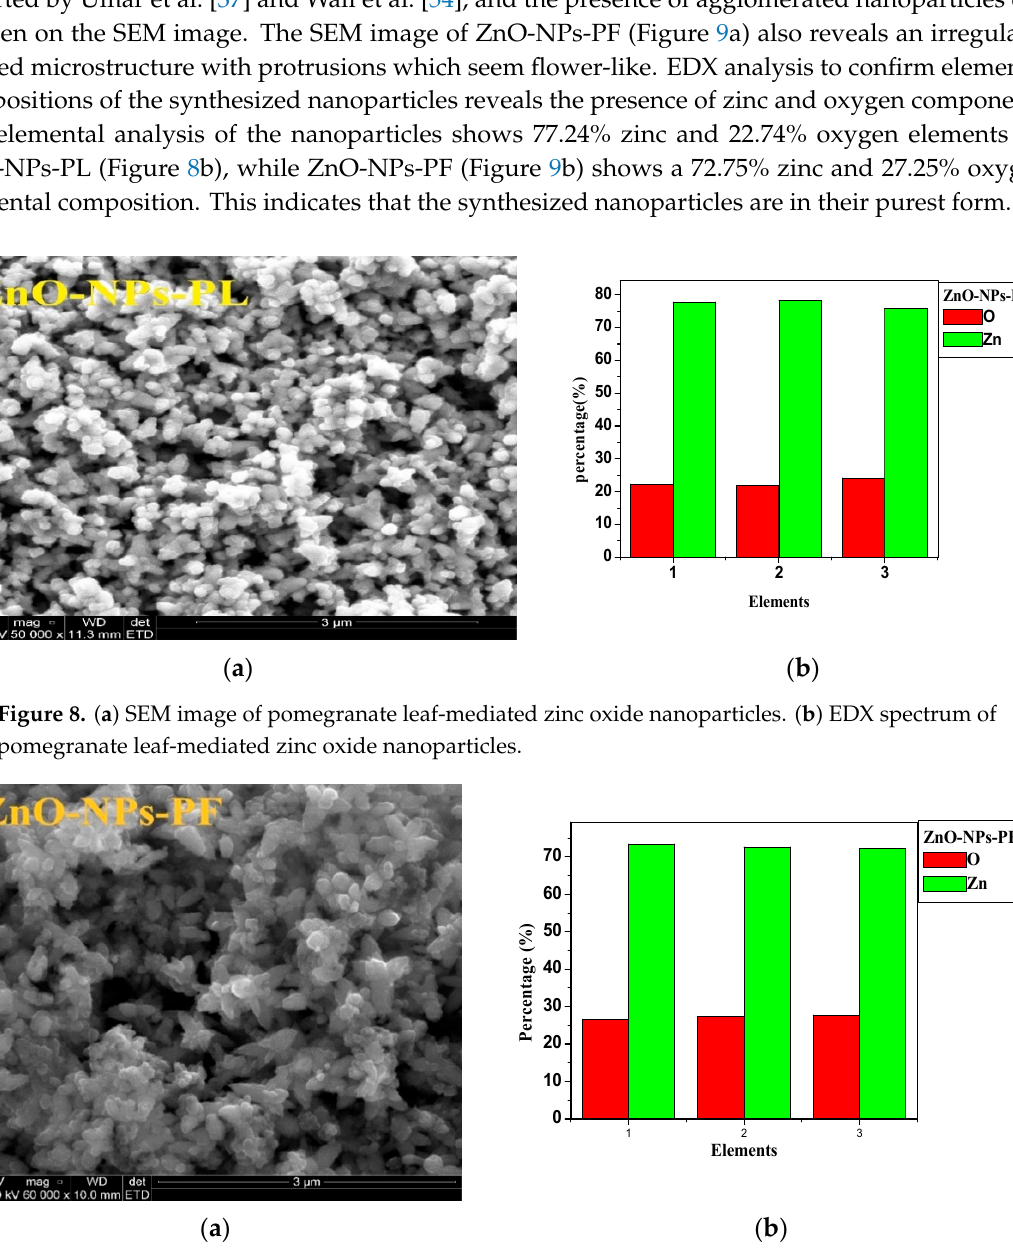
Figure 9. ( a ) SEM image of pomegranate flower-mediated zinc oxide nanoparticles. ( b ) EDX spectrum of pomegranate flower-mediated zinc oxide nanoparticles.